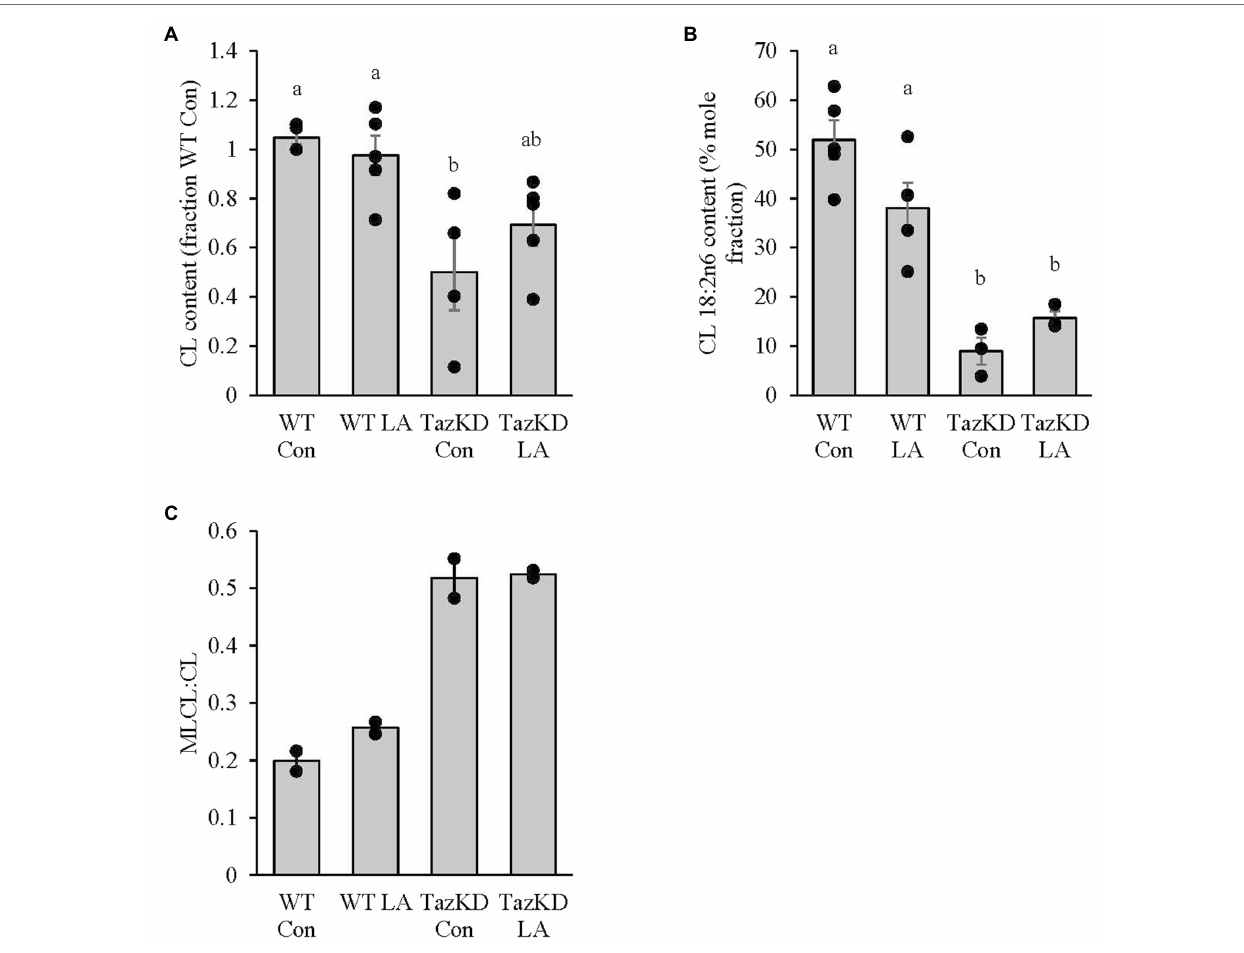
FIGURE 7 | TazKD soleus demonstrated (A) lower absolute twitch force production at higher frequencies compared to WT but no significant differences between genotypes and diet when expressed as (B) a percent of max force or (C) the frequency at 50% of maximal force (F 50 ). Values are means ± SEM, n = 3–5. WT, wild type; TazKD, Taz knockdown; Con, chow diet; and LA, linoleic acid-supplemented